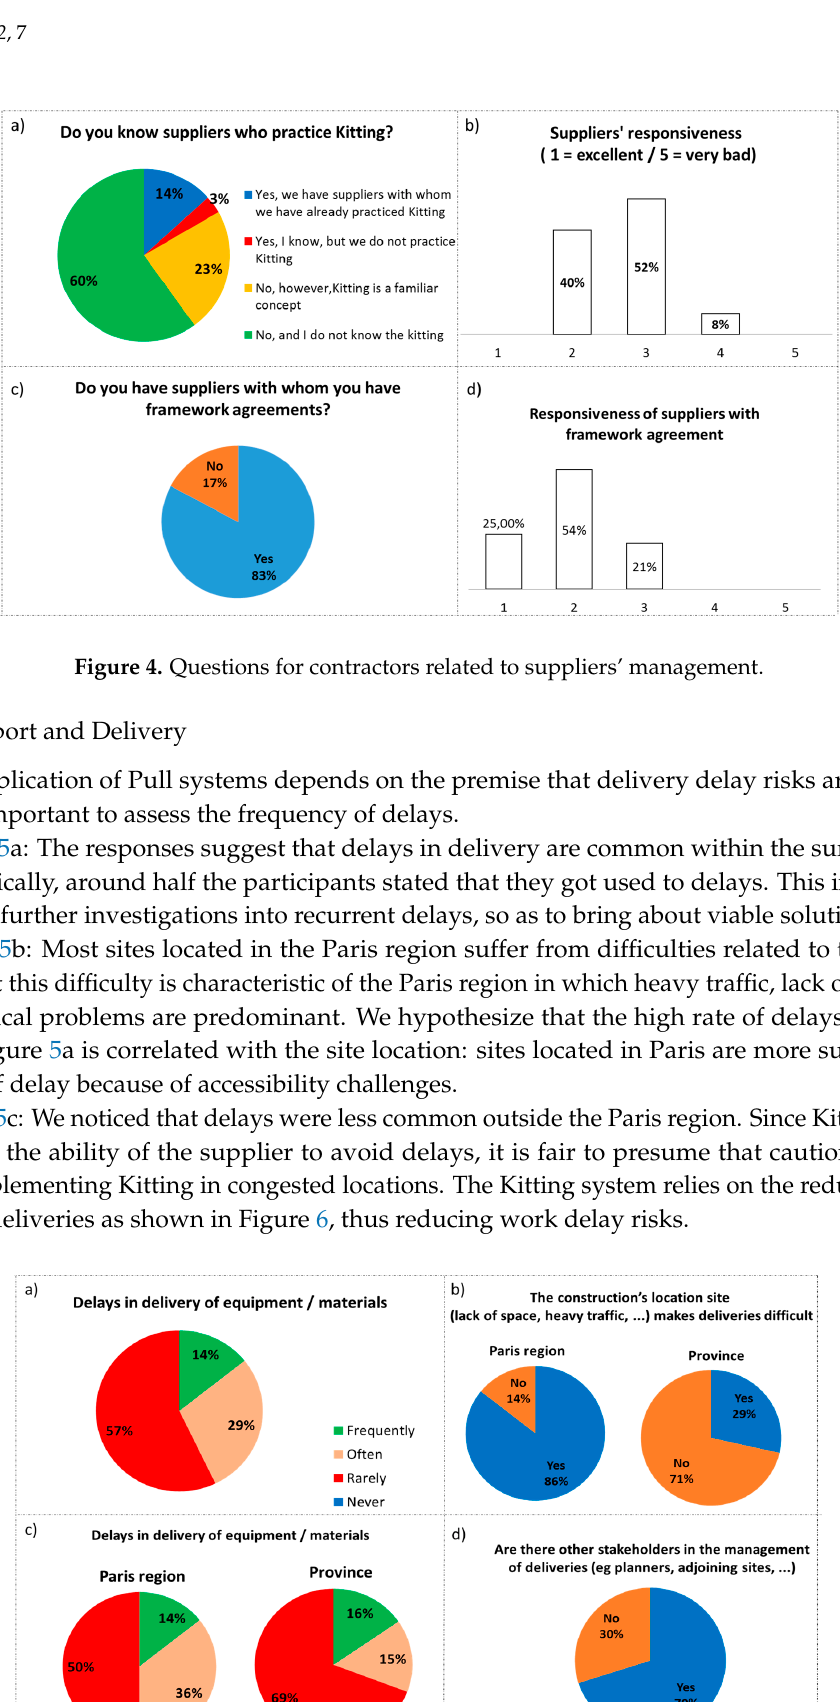
Figure 5. Questions for contractors related to transport and delivery.